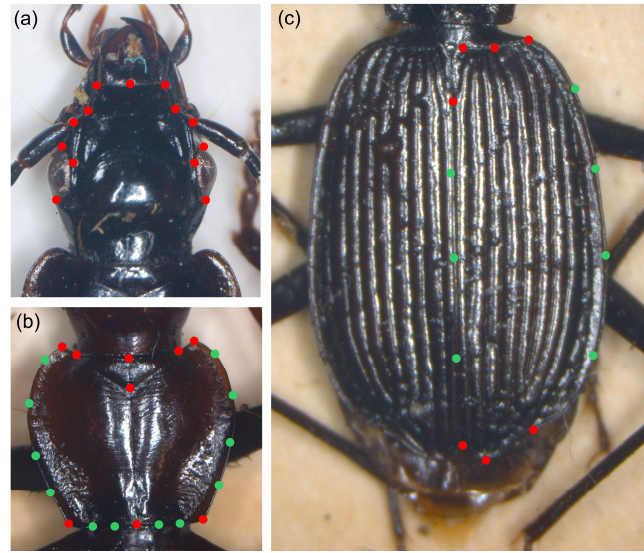
Figure 1. Configuration of landmarks: ( a ) head, dorsal view, N H = 13; ( b ) pronotum, dorsal view, N p = 21; ( c ) right elytron, dorsal view, N E = 14. Red dots = landmarks, green dots = semi-landmarks.